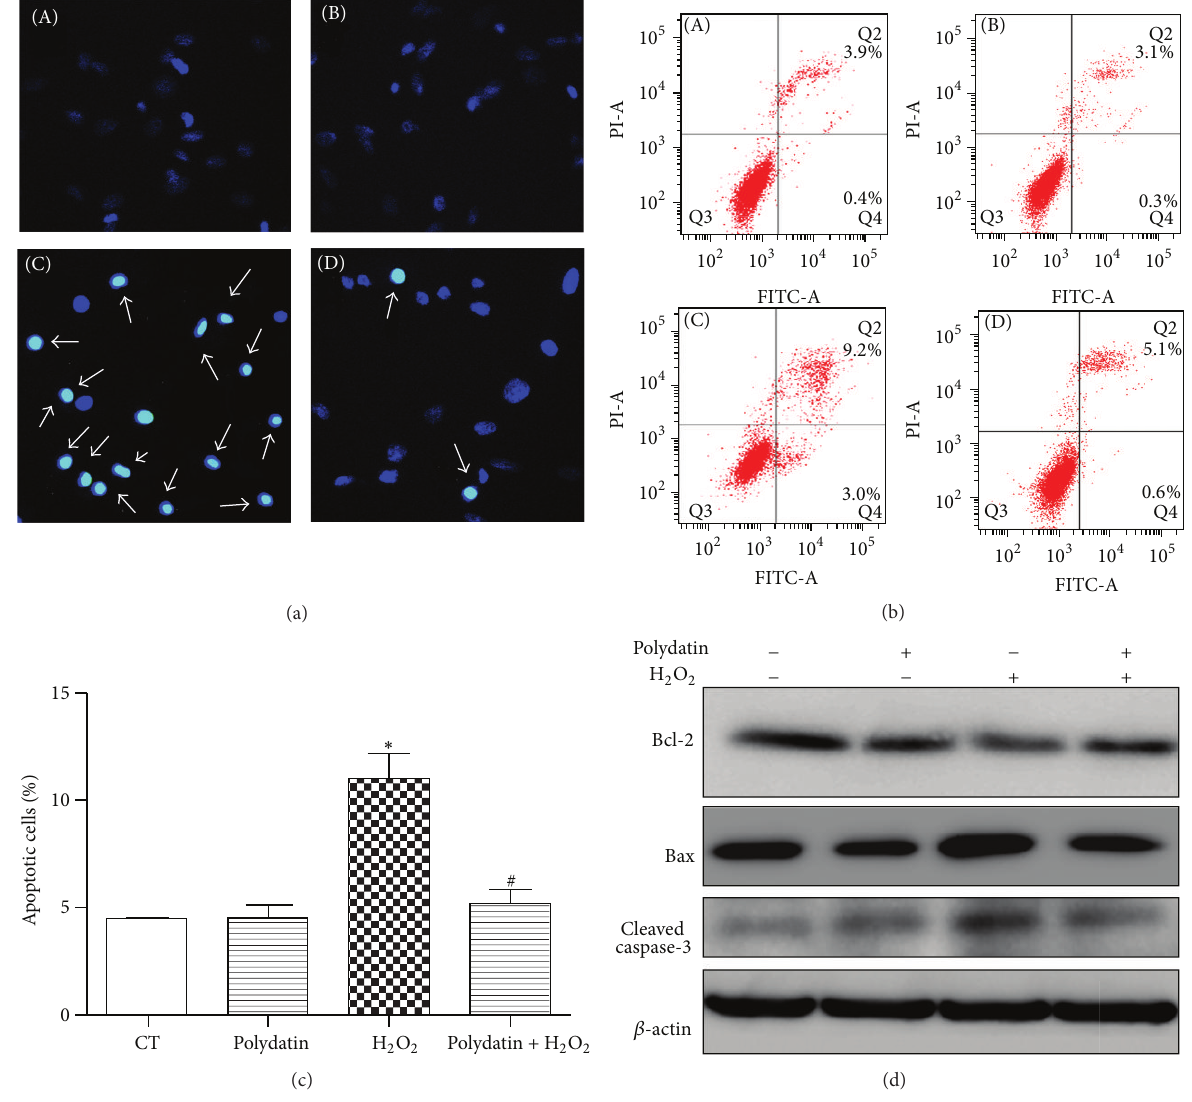
Figure 3: Polydatin attenuated H 2 O 2 -induced apoptosis in BMSCs. (a) Hochest 33258 staining was applied to detect the nuclear condensation of BMSCs, pretreated with polydatin in presence of H 2 O 2 . Fluorescence images (A–D) were observed by fluorescence microscope. (A)– (D) represented CT, polydatin, H 2 O 2 , and H 2 O 2 + polydatin group, respectively. (b) BMSCs were pretreated with 30 𝜇 M polydatin for 2